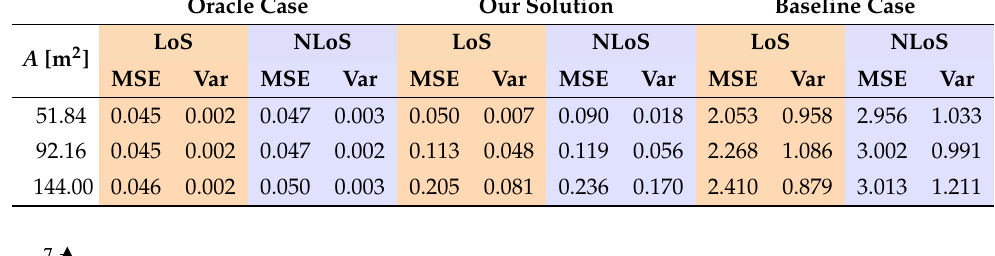
Table 4. The localization errors ( m ) of LoS (orange) and NLoS (blue) areas for the oracle/baseline cases C = 144, A = 51.84/92.16/144.00, σ = 0 and our solution when {